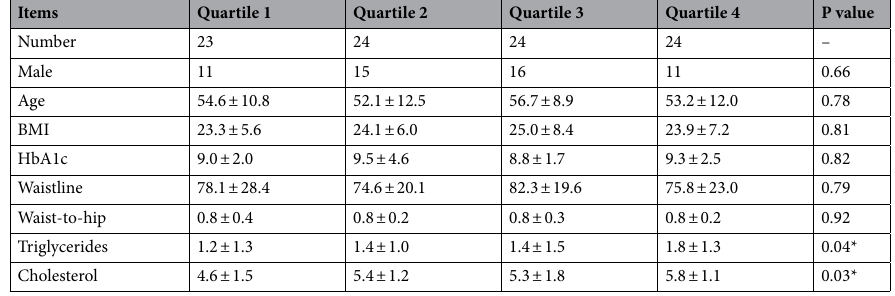
Table 1. Baseline characteristics of subjects across 4 quartiles of ErbB2 concentrations. Data were presented as means ± SD. Age (years); BMI body mass index (kg/m 2 ), HbA1c glycated hemoglobin (%), Waistline (cm), Waist-to-hip waist-to-hip ratio (%), Triglyceride (mmol/L), Cholesterol (mmol/L). *P < 0.05 (both Quartile 1 vs. Quartile 4).